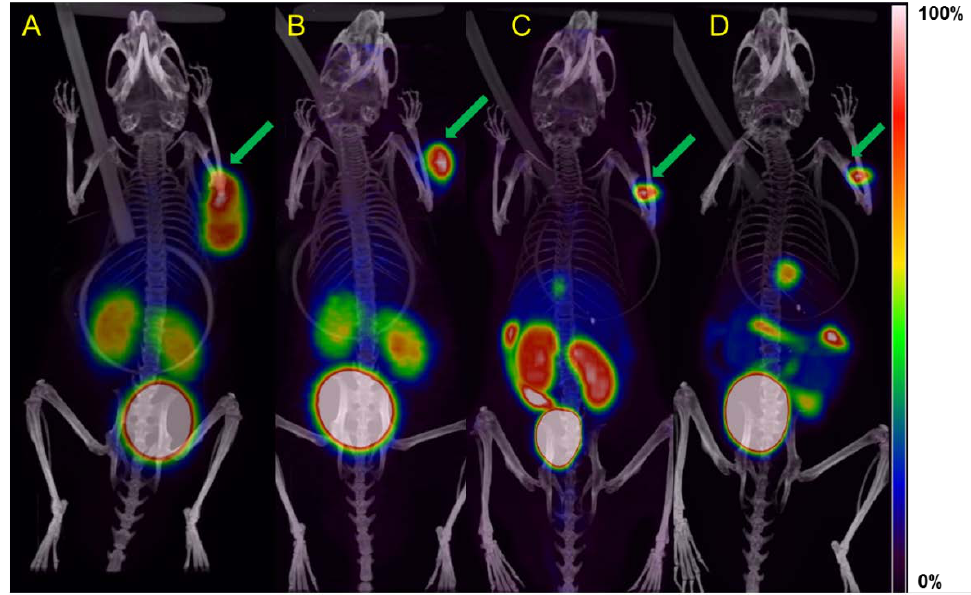
Figure 3. PET/CT MIP images of AR42J xenograft mice injected with [ 68 Ga]Ga-NOTA-NOC at 1 h ( A ), [ 68 Ga]Ga-DOTA-NOC at 1h ( B ), [ 18 F]AlF-NOTA-NOC at 1 h ( C ), and [ 18 F]AlF-NOTA-NOC at 3 h ( D ). Tumors are indicated by arrows.